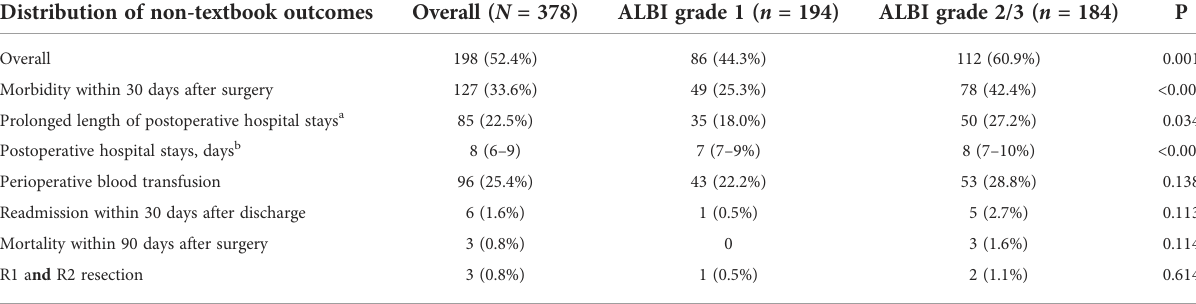
TABLE 2 Distribution of achieving non-textbook